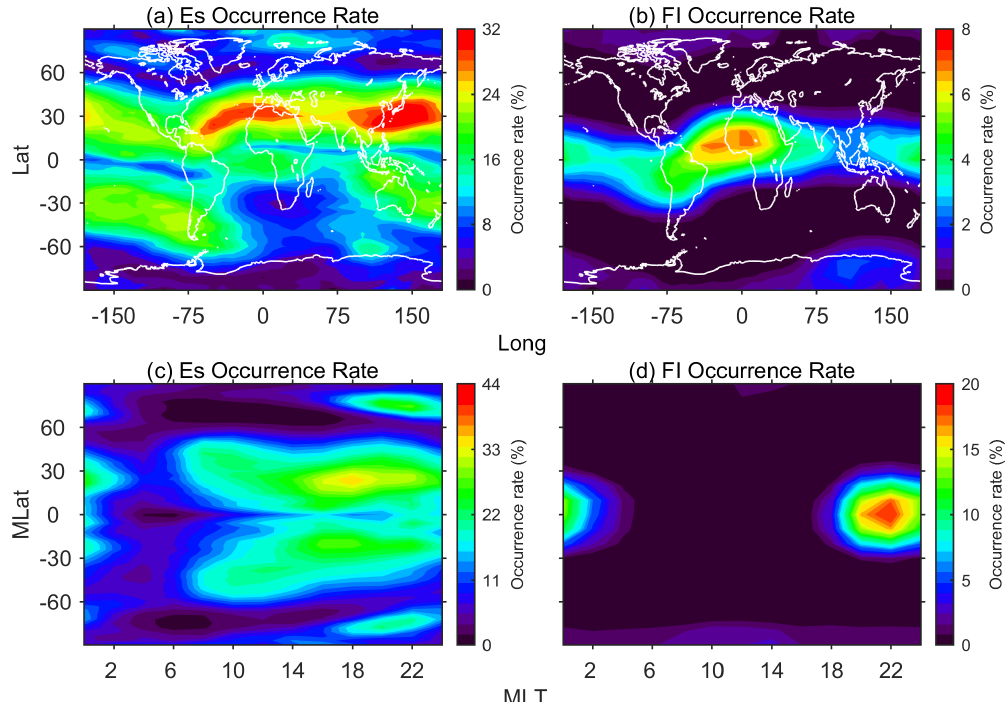
Figure 2. Global geographical (a, b) and geomagnetic distributions (c, d) of the E s (a, c) and F layer irregularity occurrence rate (b, d) during 2011–2013.